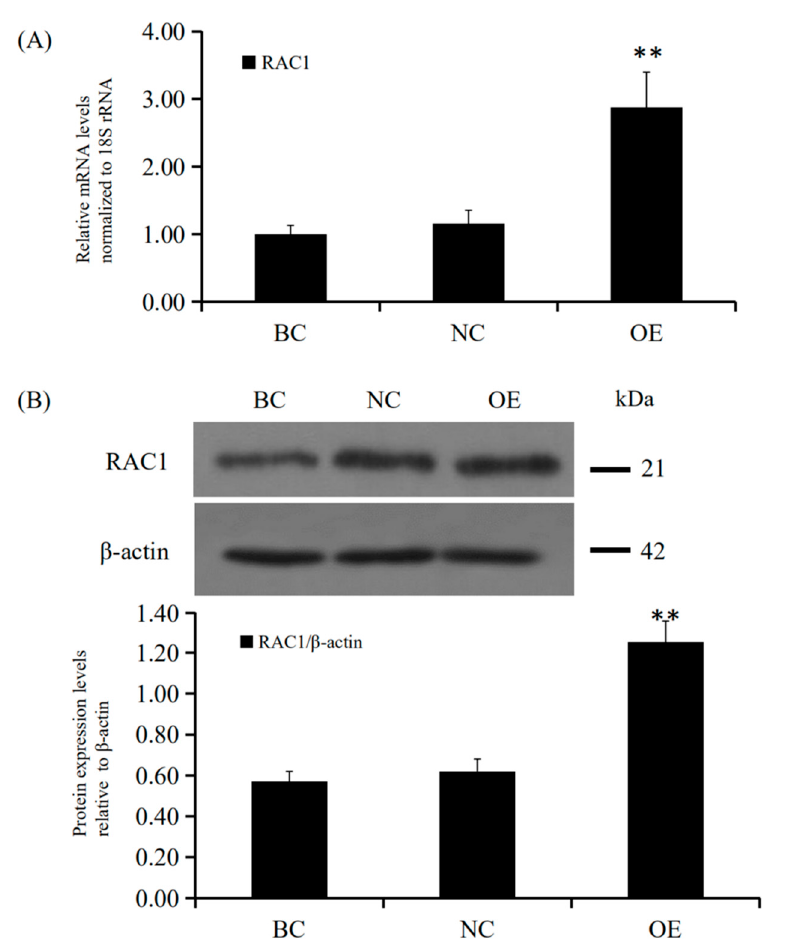
Figure 5. E ff ects of RAC1 overexpression on GC RAC1 mRNA and protein expression. Di ff erent treatment groups were transfected into GCs from the prehierarchical follicles. OE group: pYr-adshuttle-4- RAC1 vector; NC group: pYr-adshuttle-4 empty vector; BC group: absence of expression vector. ( A ) RAC1 mRNA expression was scrutinized by RT-qPCR analysis with 18S rRNA as a normalization gene. ( B ) RAC1 protein expression was detected by western blotting analysis against β -actin protein. Data represent means ± SEM ( n = 10). Bars with superscripts suggest the statistically noteworthy di ff erence in comparison to the control groups (** p < 0.01).